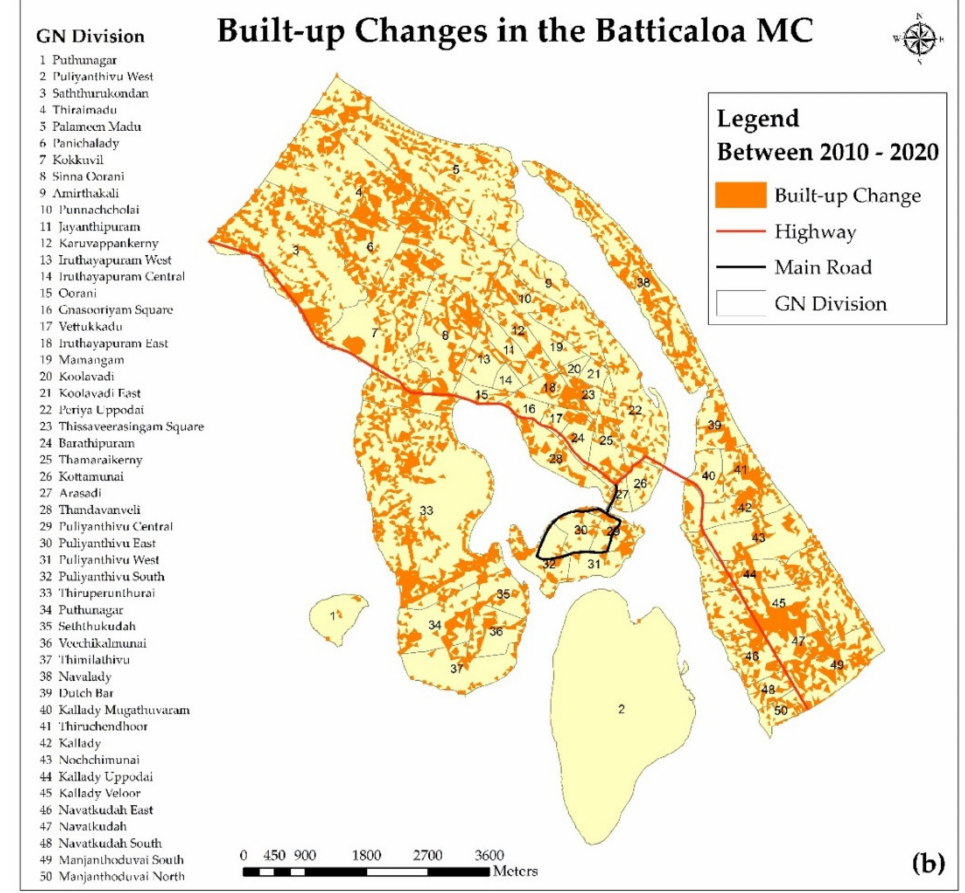
Figure 5. Built-up changes in the Batticaloa Municipal Council ( a ) between 2000 and 2010, and ( b ) between 2010 and